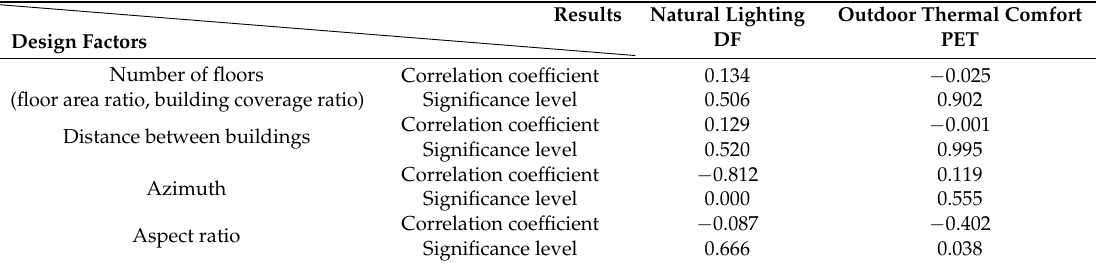
Table 7. Layout planning design factors and correlations between outdoor thermal comfort and natural